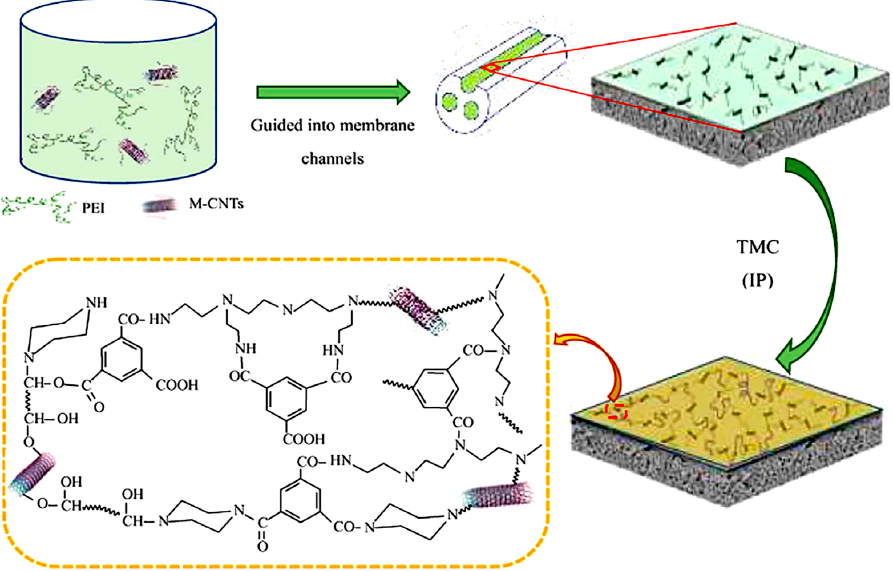
Figure 9. Schematic fabrication process of the positively charged NF membrane via interfacial polymerization with PEI as the aqueous precursor [86].